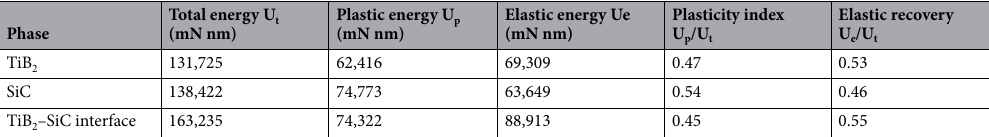
Table 3. Calculated total energy, plastic energy, elastic energy, plasticity index, and elastic recovery of different phases in C f -incorporated TiB 2 –SiC